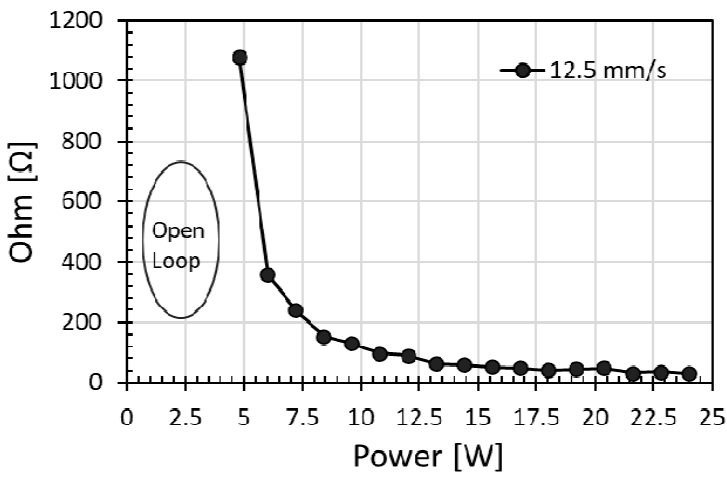
Figure 1. Electrical resistance decreased with increasing laser power with a single pass scanning at a scanning speed of 12.5 mm/s and power modulation repetition rate of 90 kHz. During laser irradiation, resistance modification was a function of both the irradiation laser power level and the irradiation time. Indeed, the modification would depend on the laser energy dose available, namely energy density (J/cm 2 ), for absorption by the material. For a constant laser spot area, the combined effect of laser power and scanning speed may be conveniently discussed with energy dose per unit length expressed as power per unit scanning speed ((W/(mm/s) = (J/mm)). Thus, instead of plotting the changes of electrical resistance with either power or scanning speed, the resistance values could be plotted as a function of energy dose per unit length as shown in Figure 2. It depicts the electrical resistance values obtained at various speeds from 5 mm/s to 35 mm/s with either 1 or 2 passes scanning at a constant laser power of 5.0 W (power density of of 3.44 W/cm 2 ). Clearly, lower resistance was produced with increasing energy dose per unit length from 0.154 J/mm at speed of 35 mm/s to 1.0 J/mm at speed of 5 mm/s. As shown in Figure 2, double the energy dose per unit length by scanning twice could significantly induce further reduction of the electrical resistance.